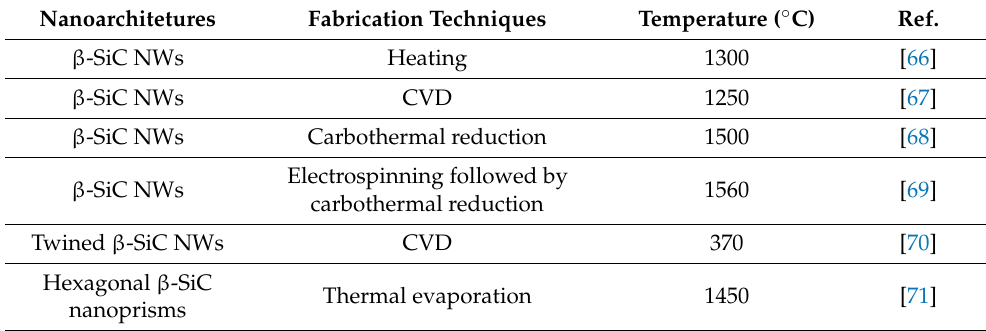
Table 1. Fabrication techniques of 1D SiC nanoarchitectures.